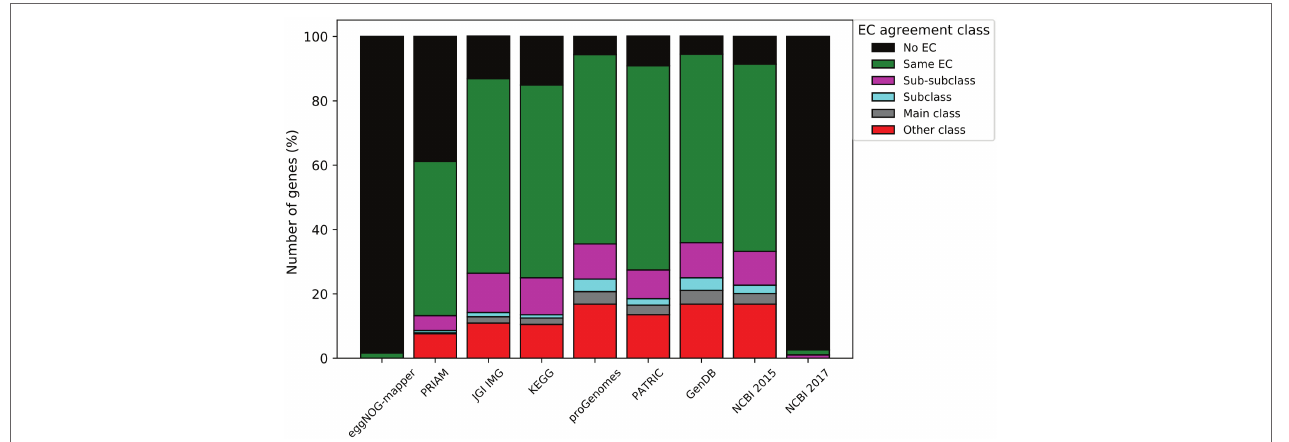
FIGURE 4 | Comparison of EC number annotations of genes in the A. pasteurianus 386B GEM with EC numbers present in other annotation sources. The levels of agreement between annotated EC numbers were classified in a sub-subclass (three first numbers identical), subclass (two first numbers identical), main class (first number identical), and other class (different first number), according to the EC classification system. The number of genes classified in each class is shown for each of the annotation sources considered.